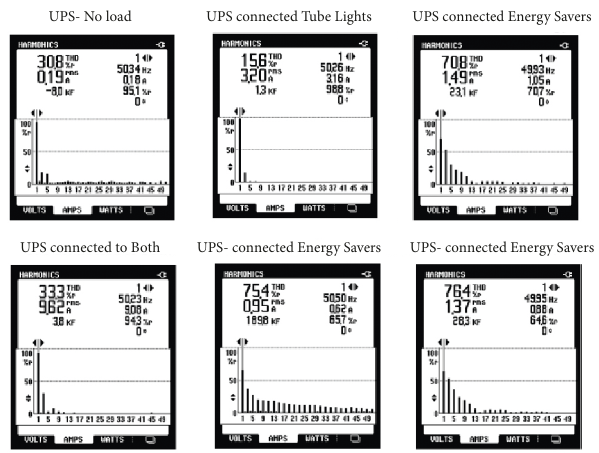
Figure 10: Experimental THD Analysis of UPS system connected with different types of linear and non-linear loads.